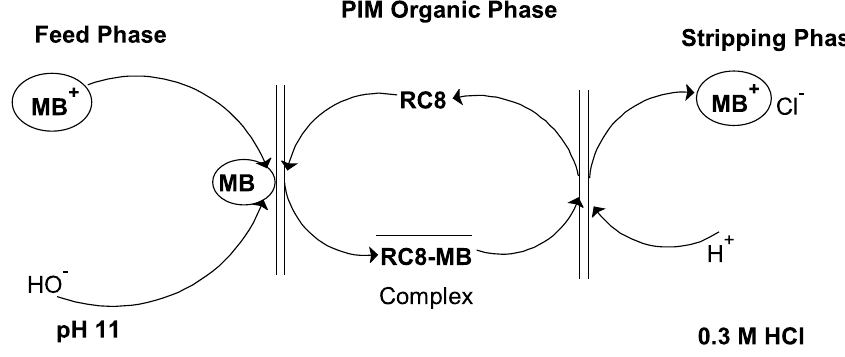
Fig. 11 The proposed mecha- nism of transport of MB through the